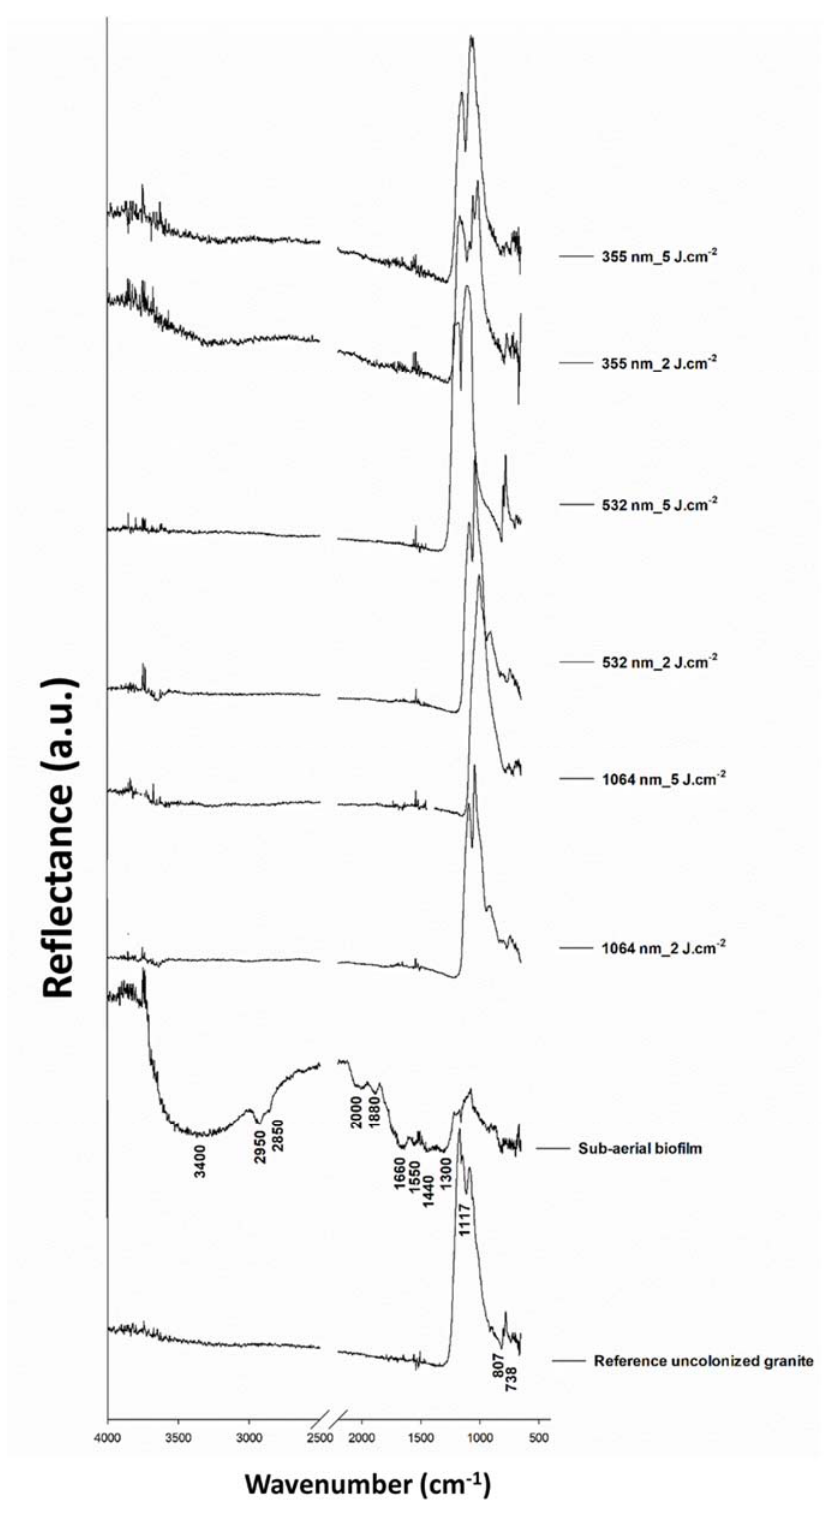
Figure 4. FTIR spectra (reflectance) of surfaces treated to extract a sub ‐ aerial biofilm (SAB) from Vilachán granite using an Nd:YAG at different wavelengths (355 nm, 532 nm, and 1064 nm) and Vilach á n granite using an Nd:YAG at di ff erent wavelengths (355 nm, 532 nm, and 1064 nm) and fluences fluences (2 J ∙ cm − 2 and 5 J ∙ cm − 2 ). (2 J · cm − 2 and 5 J · cm − 2